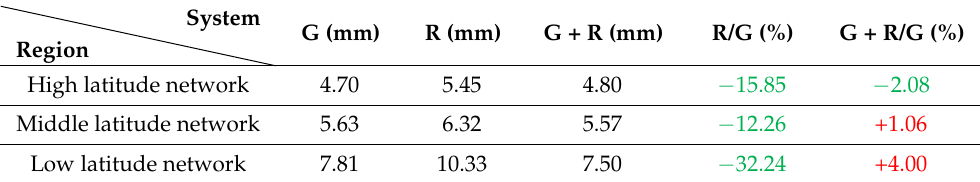
Figure 11. The RMSE of ZTDs estimated with DD processing. Table 8. The mean RMSE of ZTDs estimated with DD processing for each network and their comparison between different processing modes (The positive red and negative green values indicate the percentage increment and reduction of accuracy, respectively).